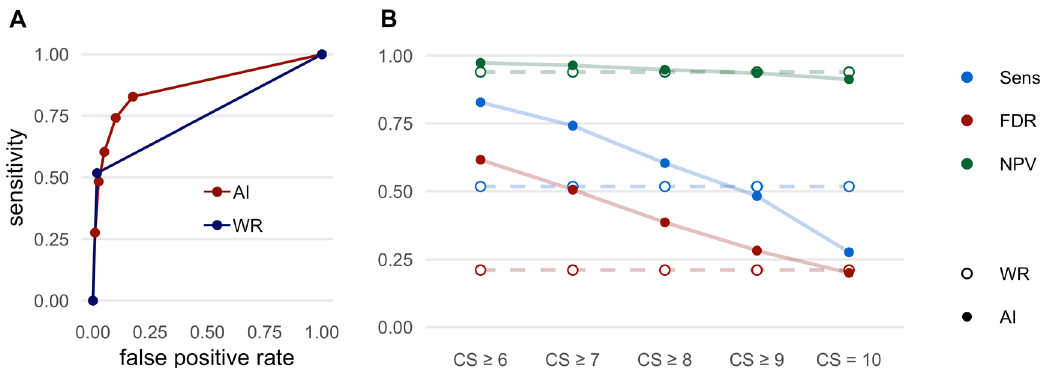
Figure 1. Performance metrics for the detection of lung lesions. ( A ) Receiver operating characteristic (ROC) curves displaying the performance of the AI Rad Companion Chest X-ray (AI) and the written report (WR) for the detection of lung lesions (area under the curve (AUC) AI = 0.867/WR = 0.750). ( B ) Sensitivity (Sens.), negative predictive value (NPV) and false discovery rate (FDR) of the AI Rad Companion Chest X-ray (AI) and the radiologists (WR = written report) for the detection of lung lesions. The sensitivity of the AI is considerably higher at a (confidence score =) CS ≥ 6; at the same time, the FDR is considerably higher. At CS = 10, the FDR is comparable to the WR, but the sensitivity is considerably lower. The NPV of the AI is high at all CS.